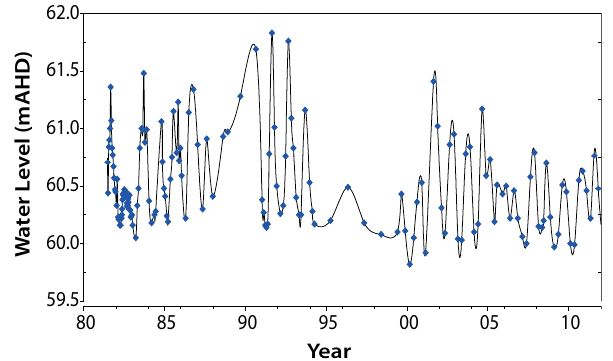
Figure 6. Historical water table fluctuations 1988–2011 for bore 108927 (Victorian Water Resources Data Warehouse, 2013). The magnitude of annual recharge cycles is coherent with those recorded in data loggers over the study period (2011 to